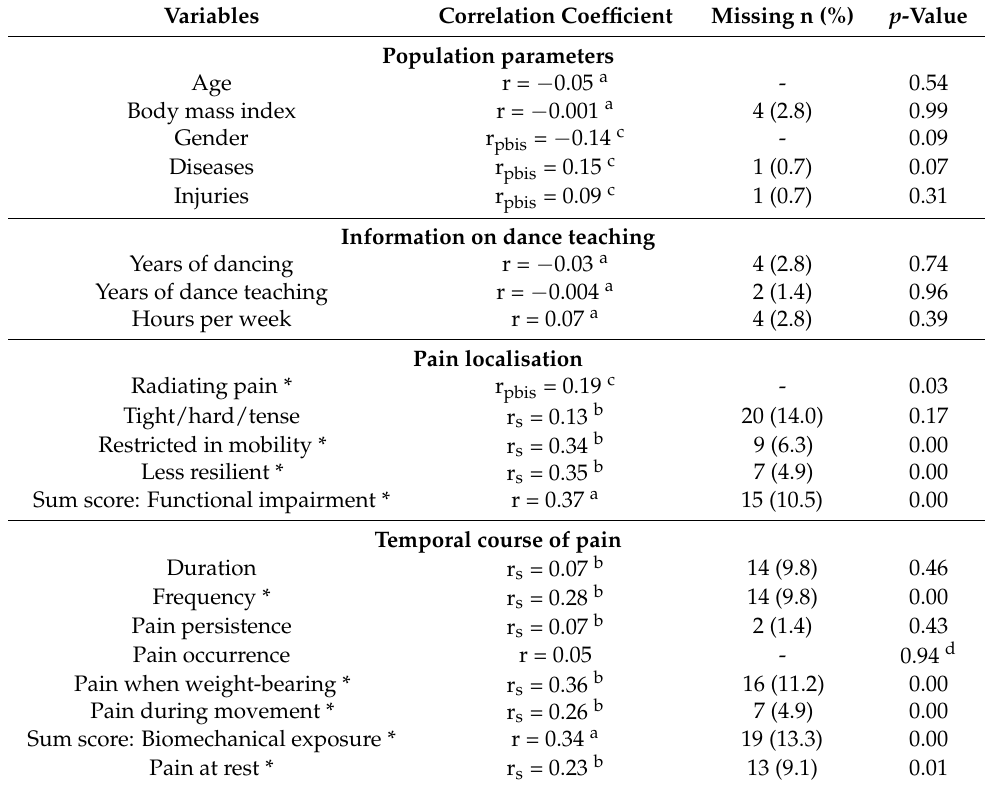
Table 2. Correlations of independent variables with pain intensity on the NRS in dance teachers (n = 143). Variables Correlation Coefficient Missing n (%) p -Value Population